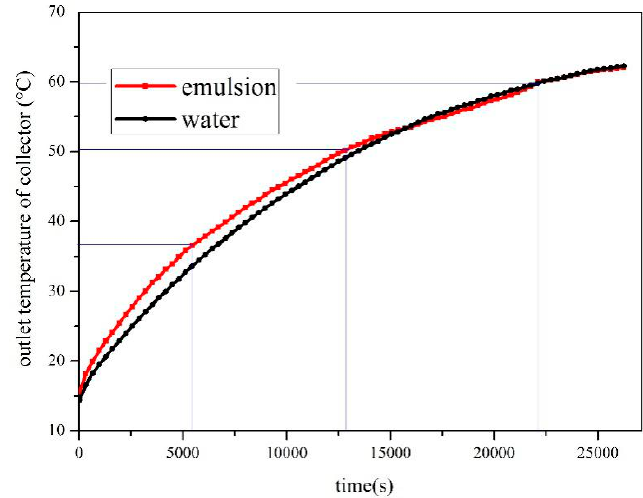
Figure 6. Outlet temperature of the solar collector.